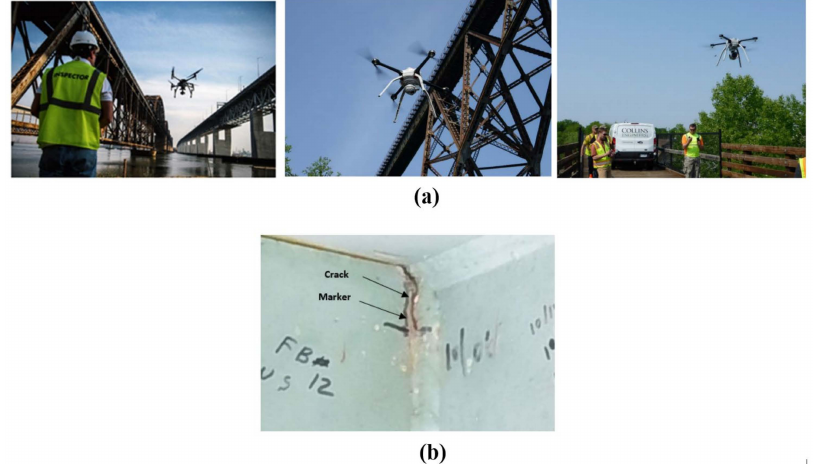
Figure 34. ( a ) Implementing aerial robot (drone) for bridge inspection [118,119]; ( b ) detected crack on a steel bridge component by the implementation of the visual inspection via aerial robot